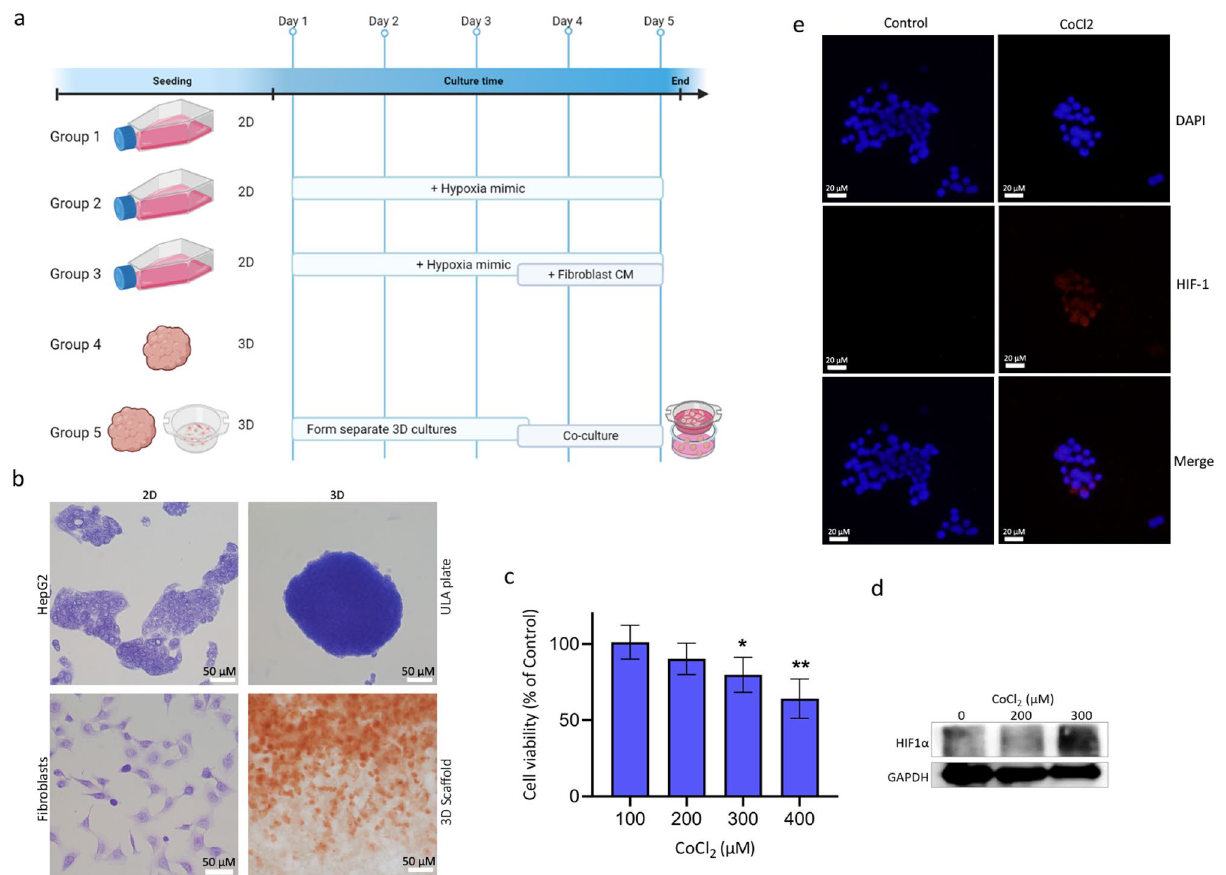
Figure 1. Experimental model and initial validations. ( a ) Schematic depiction of experimental groups. Group 1: 2D mono-culture HepG2, Group 2: 2D mono-culture HepG2 treated with CoCl 2 , Group 3: 2D mono-culture HepG2 treated with CoCl 2 and incubated with fibroblast conditioned media, Group 4: 3D mono-culture HepG2, Group 5: 3D co-culture HepG2 and fibroblasts (created with BioRender.com) ( b ) Bright field images of 2D/3D HepG2 and fibroblasts cultures fixed and stained with crystal violet and 3D fibroblasts fixed and stained with neutral red (scale bar = 50 μm). ( c ) Cell viability of HepG2 cells after treatment with increasing concentrations of CoCl 2 for 6 h (p < 0.01). ( d ) HIF1-α protein expression was detected in CoCl 2 HepG2-treated cells after 6 h of incubation. Uncropped blots are shown in Fig. S1c. ( e ) Immunofluorescence detection of HIF1-α expression and localization in HepG2 cells incubated with or without CoCl 2 (scale bar = 20 μm). 300 µM CoCl 2 was used to induce hypoxia in group 2 and 3. Panels c-e are representative of group increasing concentrations of CoCl 2 (100–400 μM) to assess cellular viability under hypoxia-mimicking condi- tions (Fig. 1c). Treatment of HepG2 with CoCl 2 did not affect cellular viability significantly at doses of 100 and